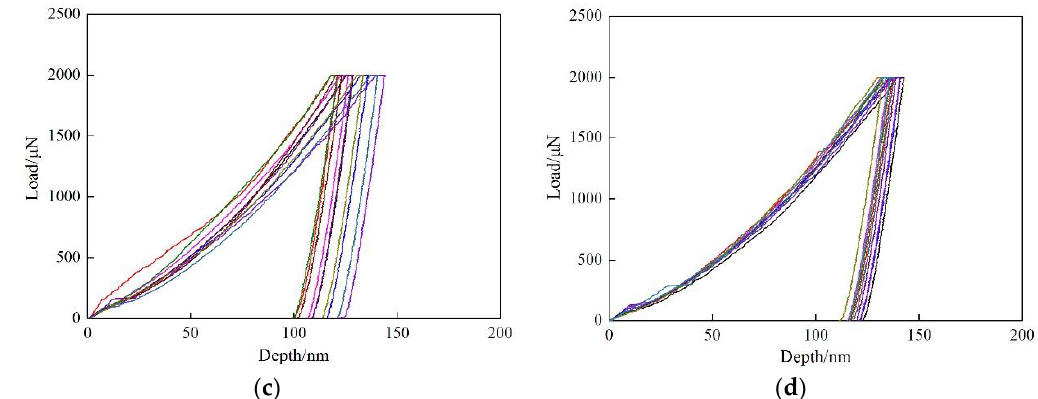
Figure 5. The load-depth curves of the tested steels. ( a ) 0.2 °C/s for Cu-free steel, ( b – d ) 0.05, 0.2 and 5 °C/s for Cu-bearing steel, respectively.